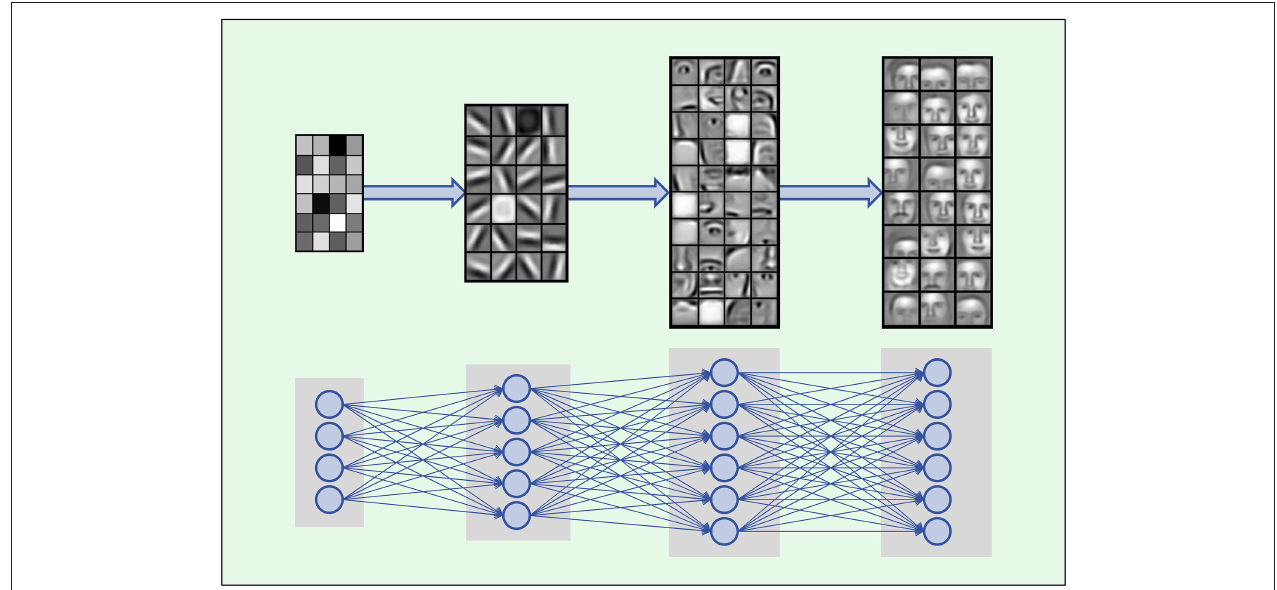
FIGURE 2 | Hierarchical composition of complex features. DNNs build a feature from simpler parts. A natural hierarchy of features arises. Input neurons represent raw pixel values which are combined to edges and blobs in the lower layers. In the middle layers contours of noses, eyes, mouths, eyebrows and parts thereof are built, which are finally combined to abstract features such as faces. Images adopted from Lee et al. (2011) with permission from the authors.